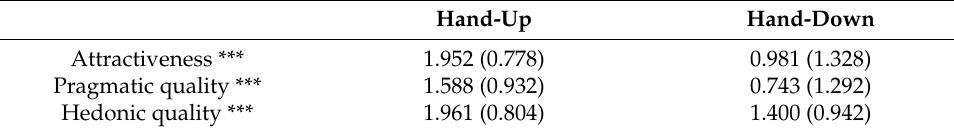
Table 1. The average and standard deviation of all user experience scores on postures.